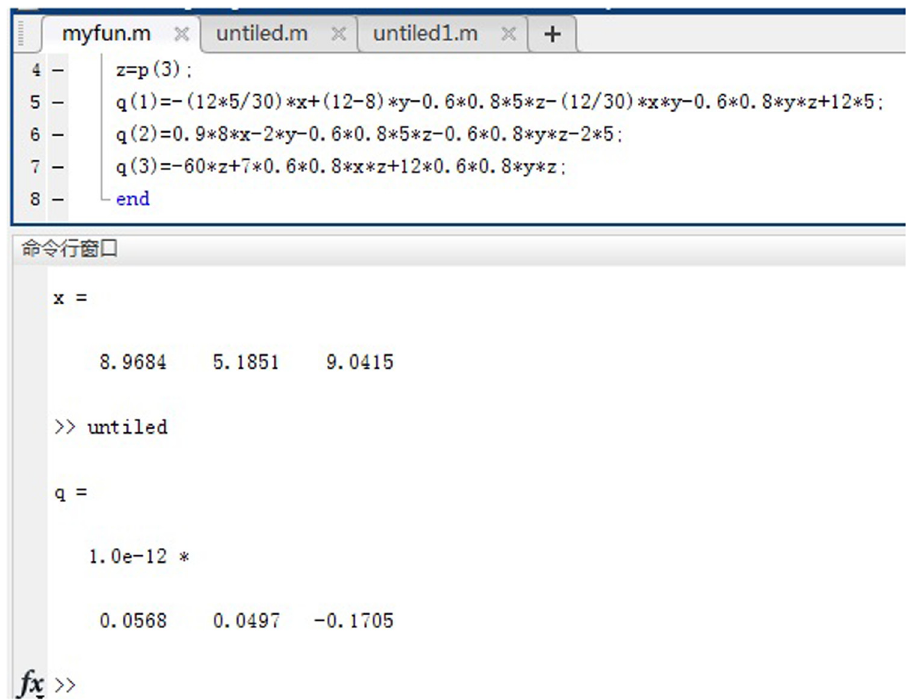
Figure 6: Bionomic equilibrium.